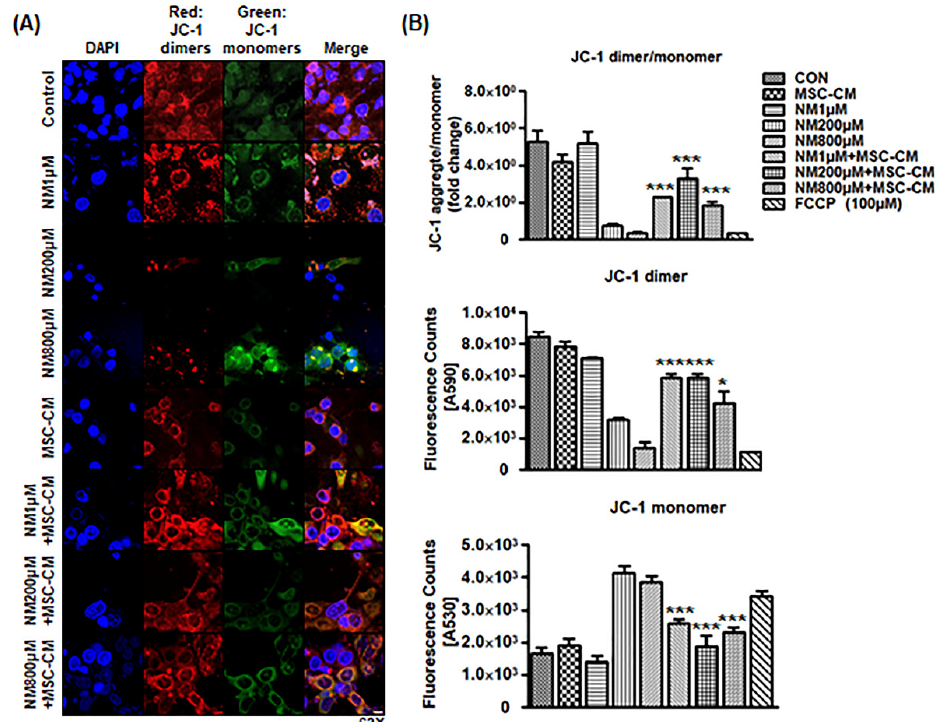
Figure 3. MSC-CM attenuates NM-exposed mitochondrial membrane potential change. ( A ) Repre- sentative brightfield images after NM exposure or NM with MSC-CM incubation. Representative fluorescence microscopy images of JC-1 dimers (red) and JC-1 monomers (green) after various doses of NM with or without MSC-CM. The merged panel presents co-localization between red dimer and green monomer fluorescence. Scale bar, 10 µ m ( B ) Fluorescence intensity of mitochondria membrane potentials (JC-1 dimer, JC-1 monomers, and JC-1 dimer/monomer) by fluorimetry. FCCP 100 µ M was used as depolarization negative control. * p <0.05, *** p < 0.001 vs. NM treated group.